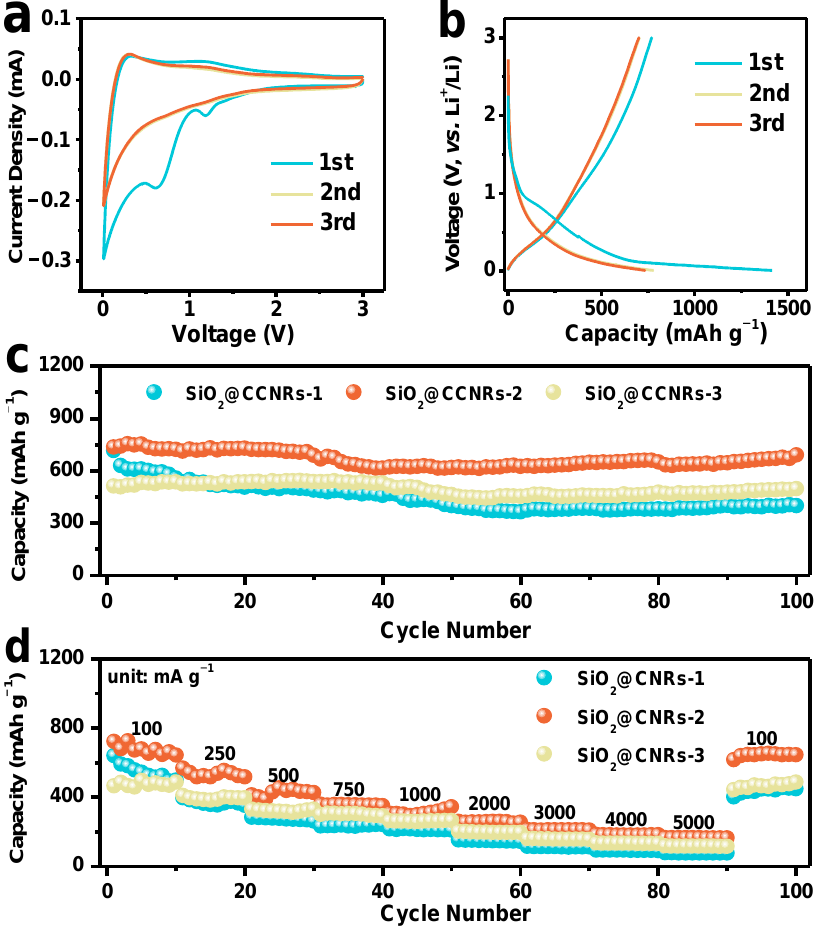
Figure 2. ( a ) Cyclic voltammogram (CV) curves of SiO 2 @CCNRs-2 cycled between 0.01 and 3.0 V (vs. Li + /Li) at a scanning rate of 0.1 mV s − 1 for the first three cycles. ( b ) Galvanostatic discharge/charge curves of SiO 2 @CCNRs-2 electrode at current density of 100 mA g − 1 for the first three cycles. ( c ) Comparison of the cycling performance of the SiO 2 @CCNRs electrode at a current density of 100 mA g − 1 for 100 cycles. ( d ) Rate performance of the SiO 2 @CCNRs electrode at different current densities.